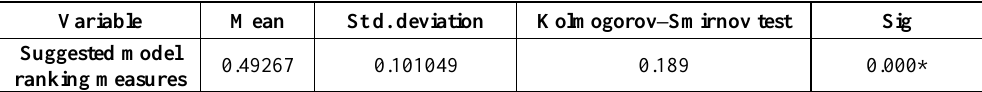
Table 4. Kolmogorov–Smirnov Normalization